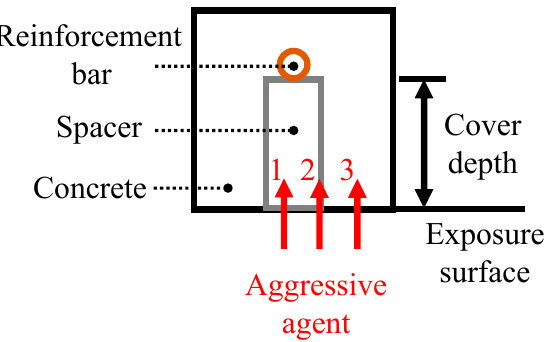
Figure 1. Schematic plot of the possible penetration paths of the aggressive agent through ( 1 ) the spacer, and ( 2 ) the interface between the spacer and concrete, and ( 3 ) the concrete.